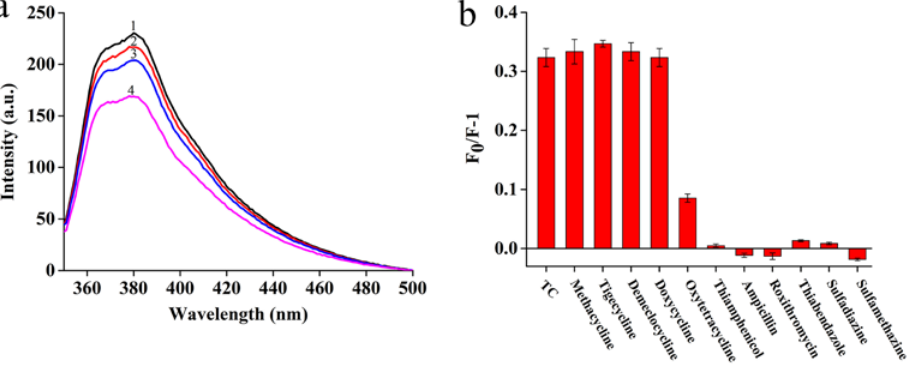
Figure 3. ( a ) Fluorescence spectra of the AdaPOF suspension solution after adding TC–methanol solution at different concentrations (curves 1–4 represent TC concentrations of 0, 0.1, 0.5 and 1.0 μmol/L, respectively; λex = 334 nm); ( b ) Study on the selectivity of AdaPOF ( c AdaPOF = 0.15 mg/mL; c antibiotics = 1.0 μmol/L, λex = 334 nm).